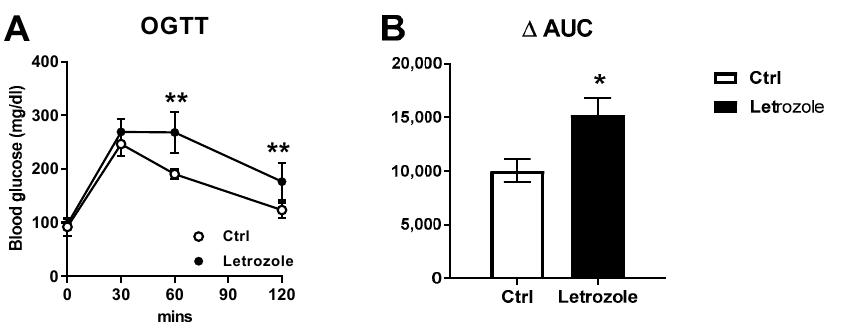
Figure 8. The oral glucose tolerance test (OGTT) was performed on the control and the letrozole- treated mice. The curves of plasma glucose ( A ) after glucose administration are shown. Using the ∆ AUC calculation, the letrozole-treated mice showed significantly higher levels than the control mice ( B ). The results are expressed as the mean ± SD. * p < 0.05; ** p < 0.01, compared with the control mice.